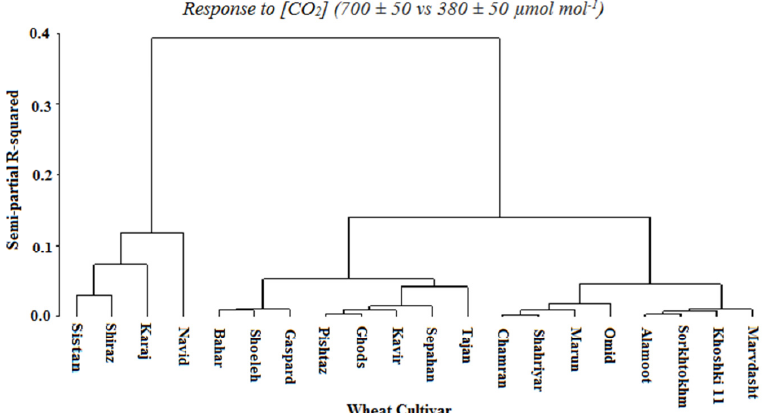
Fig. 1. Hierarchical cluster analysis: Dendrogram using the Ward Method and the variables consisting of nitrogen concentration, nitrogen content, NUE, leaf area, plant height, root volume, chlorophyll a , chlorophyll b , carotenoid concentration, shoot dry weight, root dry weight and shoot/ root dry weight (S/R) ratio in 20 Iranian bread wheat cultivars. Based on changes (%) in the measured values of the variables for an elevated [CO ] concentration of 700 vs the ambient concentration of 380 µmol mol 2